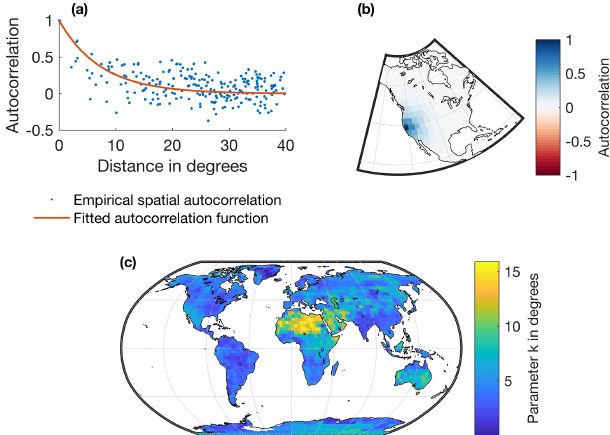
Figure 3. Illustration of the spatial autocorrelation of the empirical model residuals and their representation in the SAR model (for the GRACE-REC product based on MSWEP and calibrated with JPL mascons). (a) Empirical and fitted spatial autocorrelation functions for the model residuals at a given 3 ◦ × 3 ◦ mascon in California. (b) Fitted spatial autocorrelation at that mascon. (c) Fitted parame- ter k (Eq. 11), which conditions the steepness of the autocorrelation function (high values are equal to high autocorrelation length of the